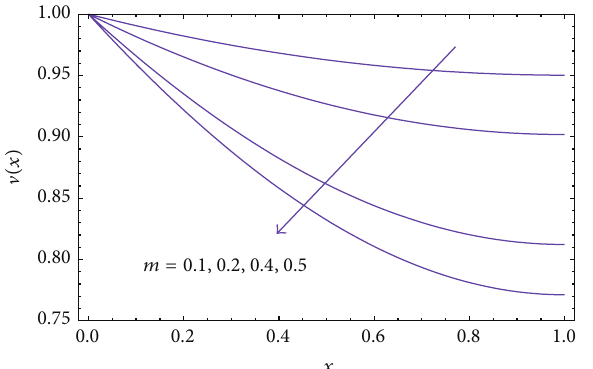
Figure 3: Effects on velocity profile for various values of 𝑚 at 𝛽 = 0 . 5.